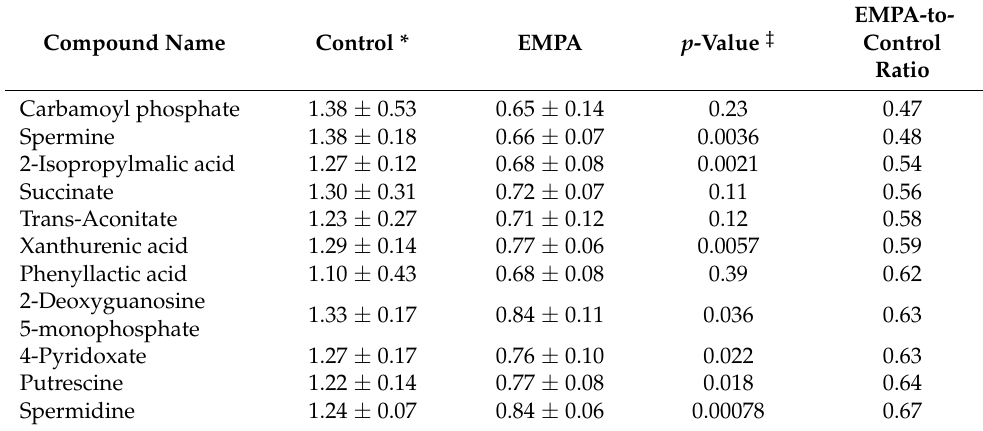
Table 1. Metabolites † down-regulated by empagliflozin in kidney (10